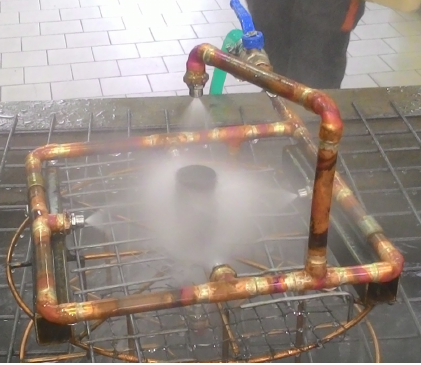
Figure 3. Cooling of